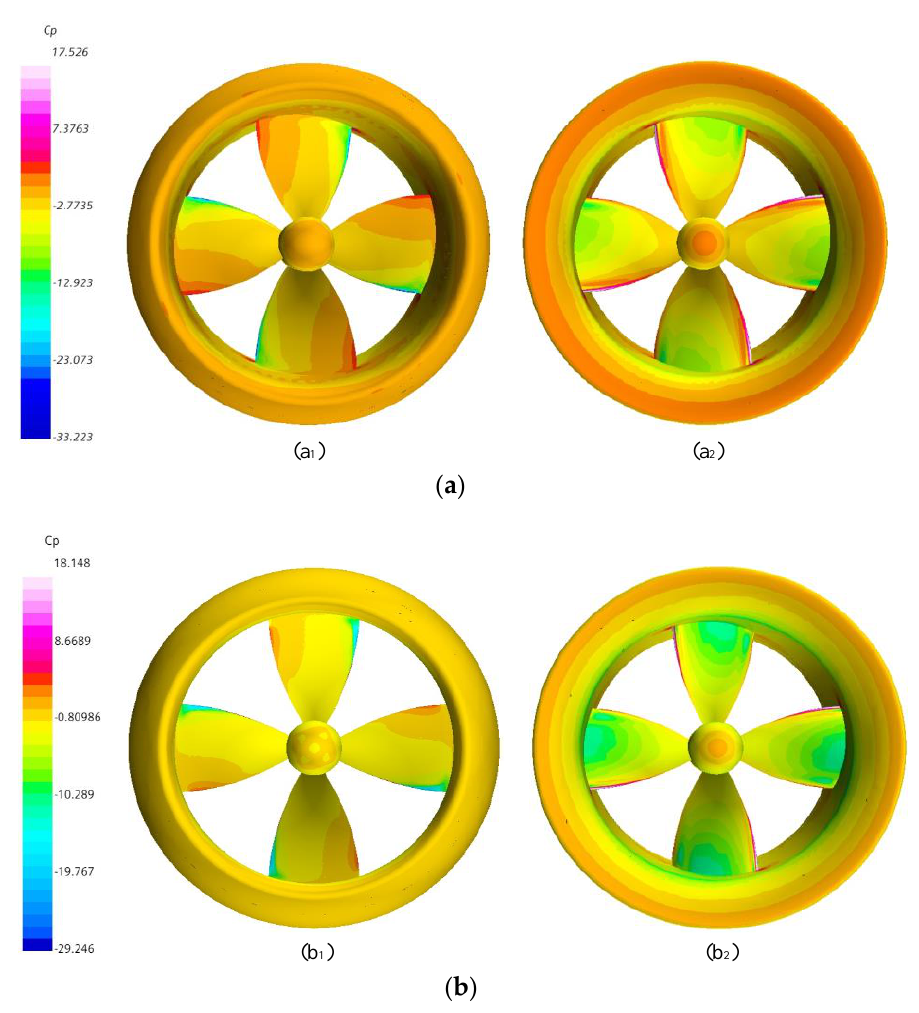
Figure 10. Pressure distribution of the RDT. ( a ) Prototype RDT. ( b ) Optimized RDT.